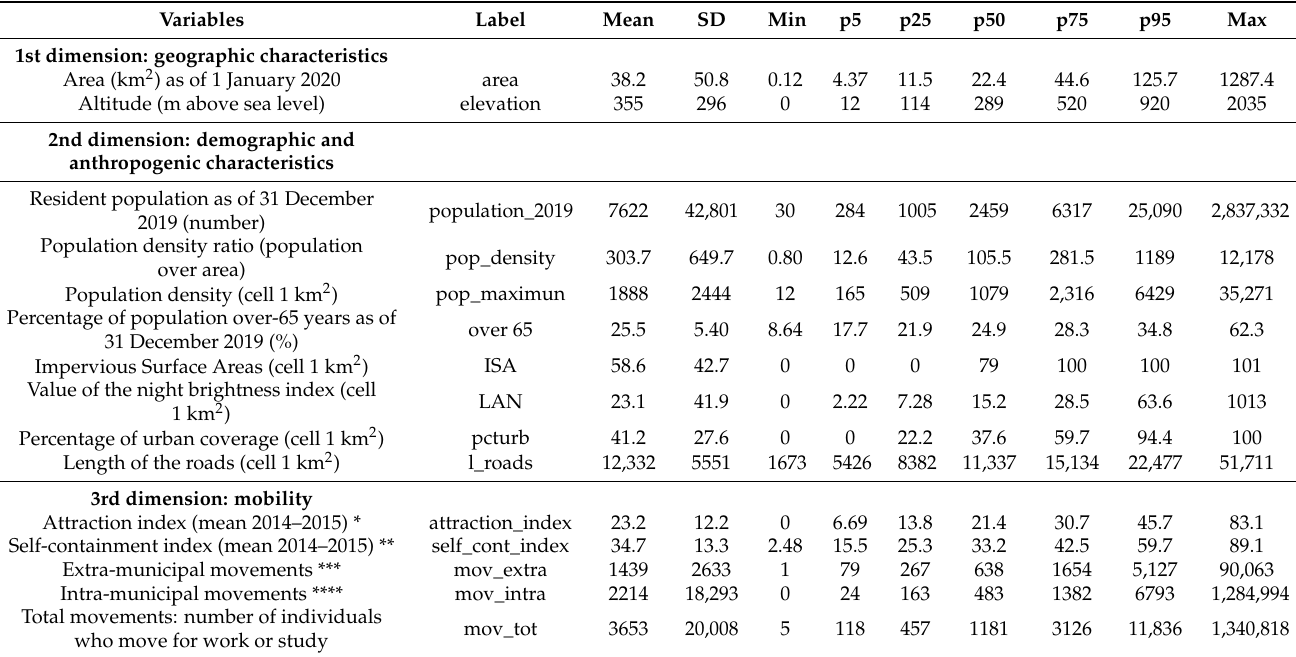
Table 1. Characteristics # of the contextual continuous variables for each dimension under study and air pollution exposure across the 7903 Italian